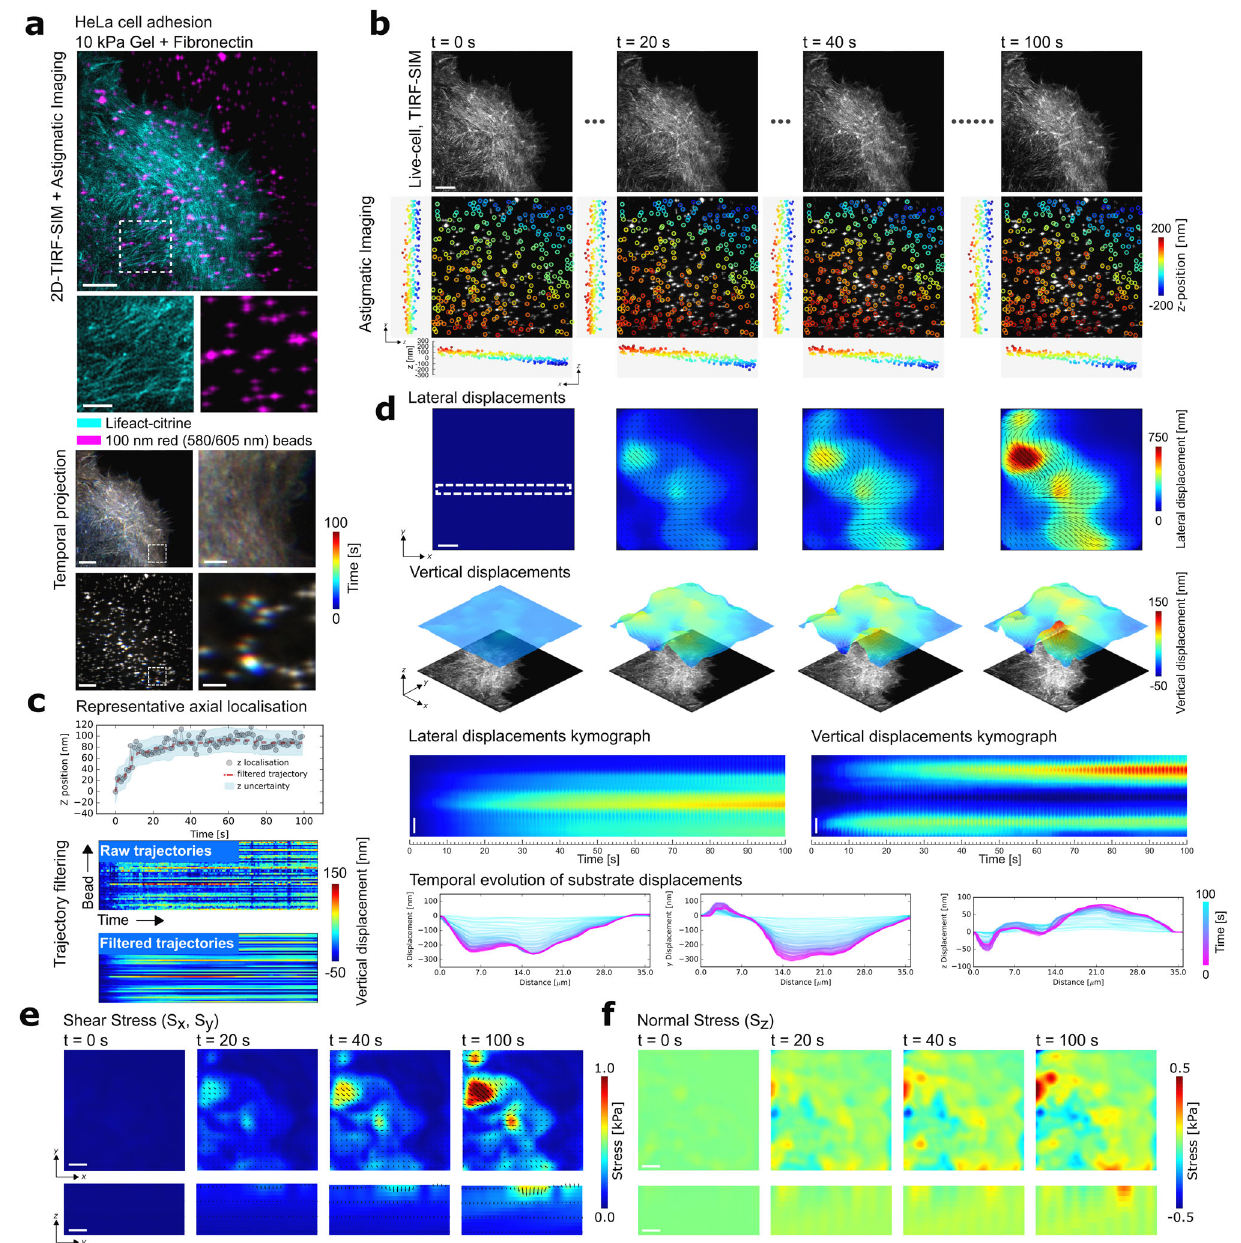
Fig. 2 Quantifying out-of-plane force generation during HeLa cell adhesion using aTFM. a Upper: TIRF-SIM imaging of a HeLa cell expressing Lifeact- citrine (cyan) adhering to the elastic substrate loaded with fl uorescent marker beads (magenta) imaged using the aTFM setup. Scale bar is 5 µ m. Lower: colour-coded temporal projection of the TIRF-SIM cell image as well as the astigmatic bead image. Scale bar is 5 µ m. Zoom in of dashed box has a scale bar of 1 µ m. b Upper: TIRF-SIM snap shots of the HeLa cell over the course of the 100 s, 100 frame movie. Lower: Astigmatic bead image overlaid with a scatter plot showing their lateral positions colour coded by their axial positions over time. In addition, the lateral orthogonal projections of the bead positions are plotted. Scale bar is 5 µ m. c Upper: Plot showing the axial position of a representative raw bead trajectory (grey dots) as well as the fi ltered position (red) and displacement uncertainty as derived in Fig. 1c (blue region). Lower: Panel showing all un fi ltered trajectories (upper) and median fi ltered trajectories (lower). d Upper: Snap shots of the magnitude of lateral displacements resulting from HeLa cell adhesion over the course of the 100 s, 100 frame movie and surface plots of the corresponding vertical displacement of the gel. The cell image is displayed below to facilitate correspondence of displacements with cellular structures. Scale bar is 5 µ m. Lower: Both kymographs and line plots showing the continuous temporal evolution of the lateral and vertical surface displacements over the course of the recording. Scale bar is 5 µ m. e Upper: Snap shots of the magnitude of shear stress resulting from HeLa cell adhesion. Lower: cross-section of the gel showing the distribution of shear stress through the bulk of the gel. Scale bar is 5 µ m. f Upper: Snap shots of the magnitude of normal stress at the gel surface. Lower: cross-section of the gel showing the distribution of normal stress through the bulk of the gel. Scale bar is 5 µ